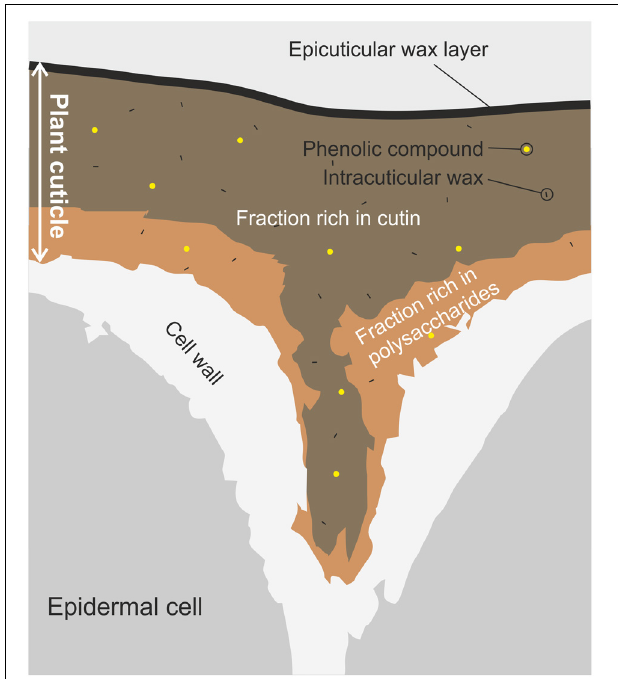
FIGURE 1 | Schematic diagram of a transverse section of a plant cuticle. The figure shows the typical shape of the plant cuticle between two epidermal cells. Main components and their space distribution are displayed: the layer below is rich in polysaccharides from the cell wall, while the top layer is mainly constituted by cutin with a last layer of epicuticular waxes. Intracuticular waxes and phenolic compounds are spread through the plant